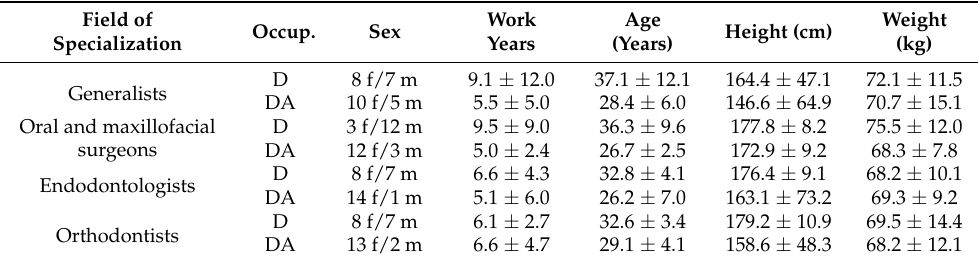
Table 1. Socio-demographics of dentists (D) and dental assistants (DA) for each field of specialization. The mean values with standard deviations are shown. Field of Specialization